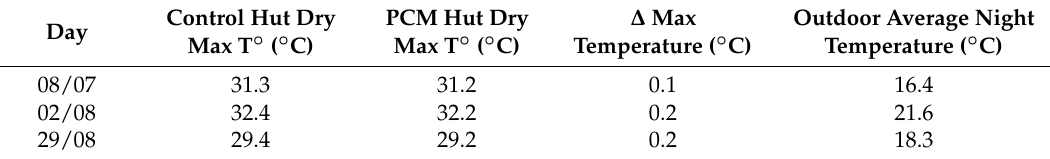
Table 6. Maximum temperature of the huts for summer days with hot nights.